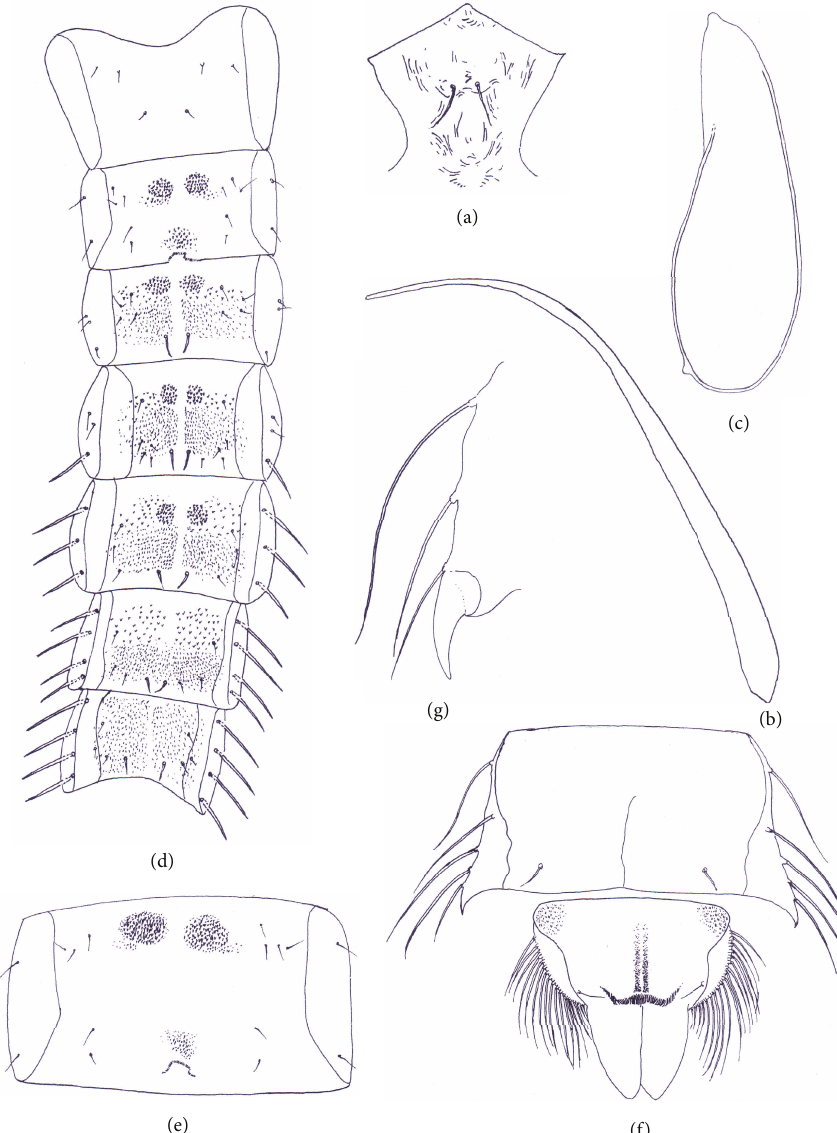
Figure 2: Rheotanytarsus nudicornus n. sp., pupa: (a) frontal apotome; (b) thoracic horn; (c) wing sheath; (d) tergites I–VII; (e) tergite II; (f) tergite VIII and anal lobe; and (g) caudolateral spur.